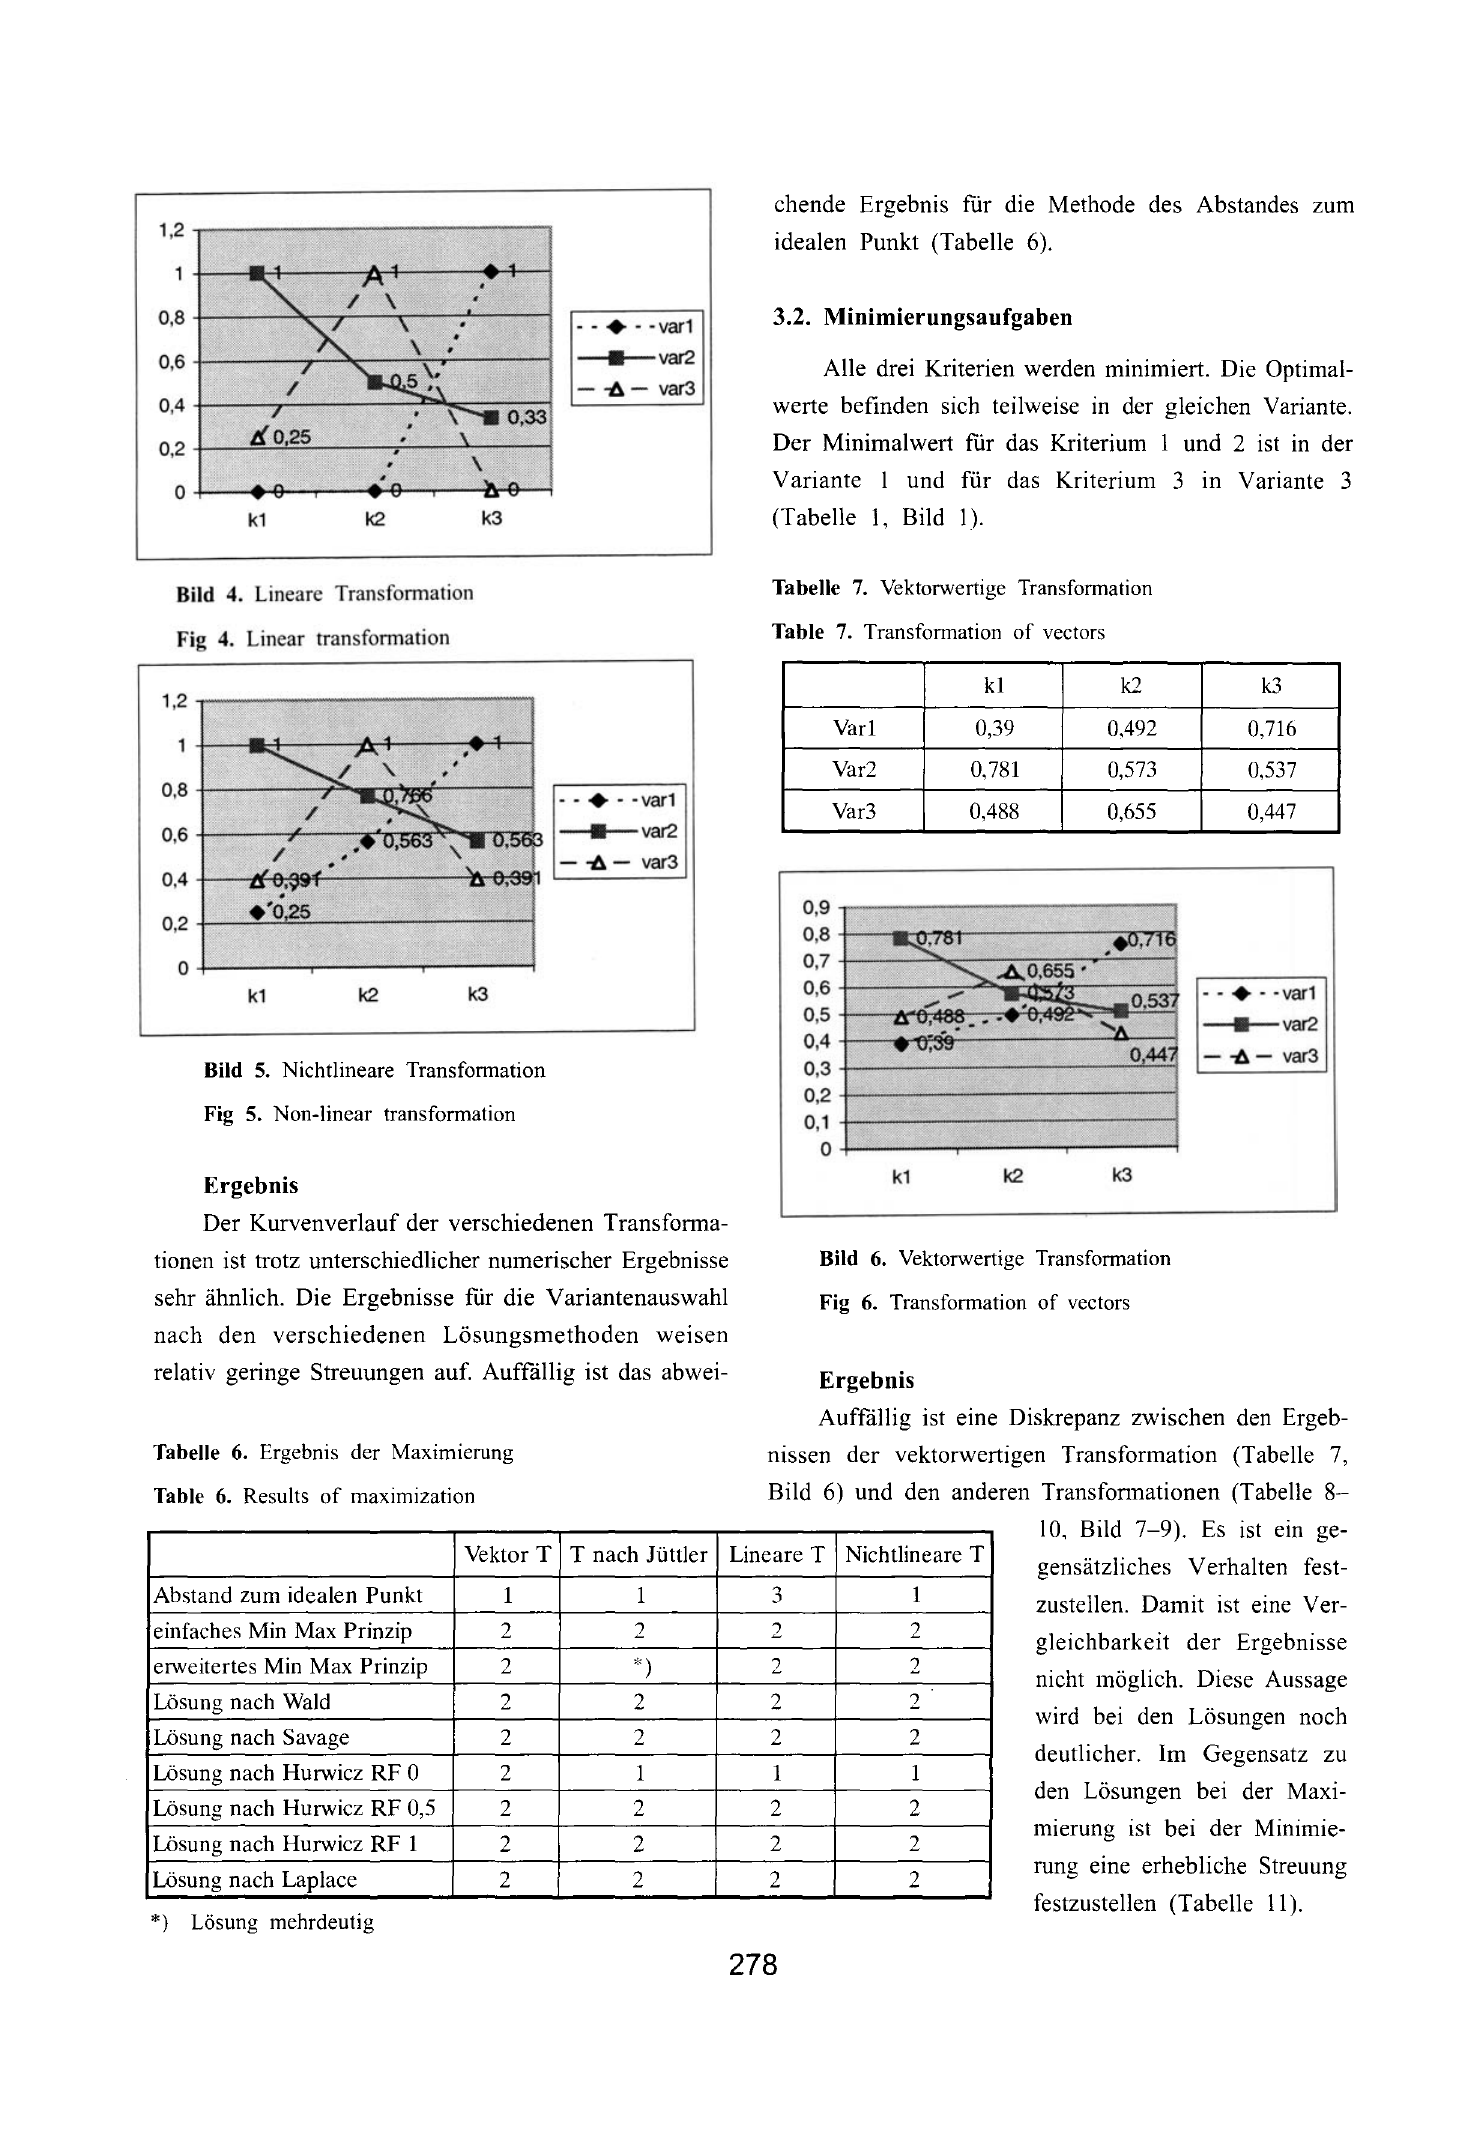
Tabelle 7. Vektorwertige Transformation Table 7. Transformation of vectors